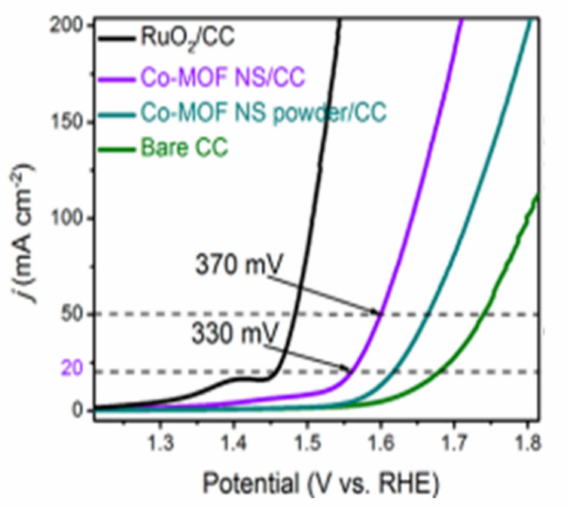
Figure 18. LSV curves of RuO 2 /CC, Co–MOF NS/CC, Co–MOF NS powder/CC, and bare CC at 2 mVs − 1 in 1.0 M KOH. Reproduced with permission from